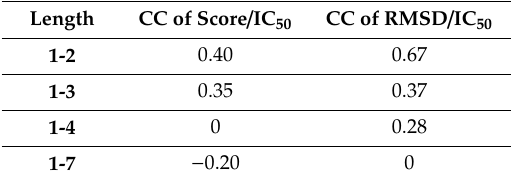
Table 1. Docking simulation and IC 50 measurements of BMS-8 and amino-X s . Table 2. Correlation coe ffi cients (CC) for IC 50 vs. Score and IC 50 vs.